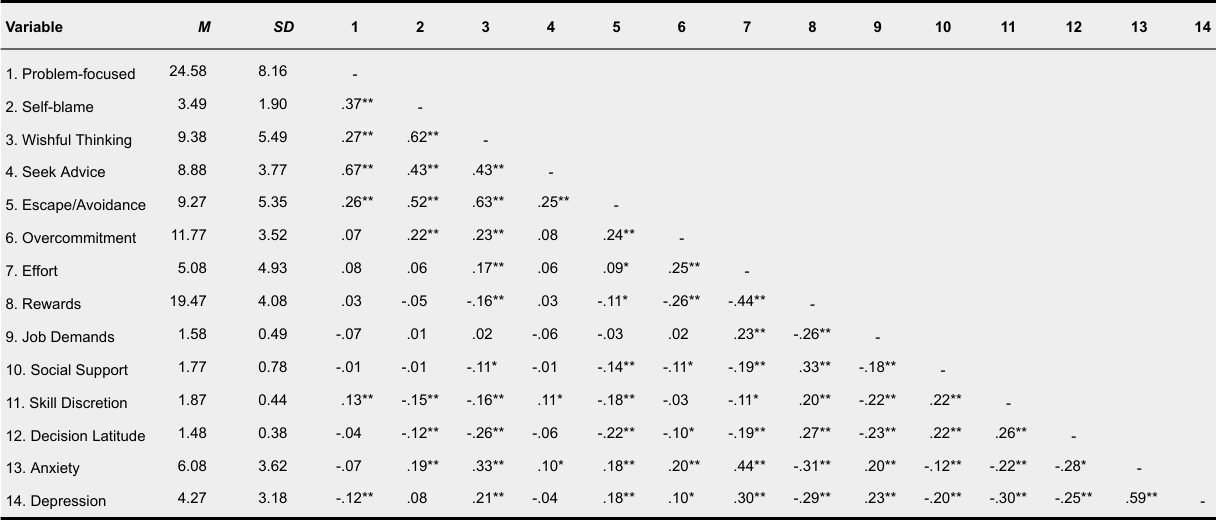
Descriptive Statistics and Correlations Between Coping Strategies, DCS and ERI Dimensions, Anxiety and Depression in Italian Nurses (N = 450)